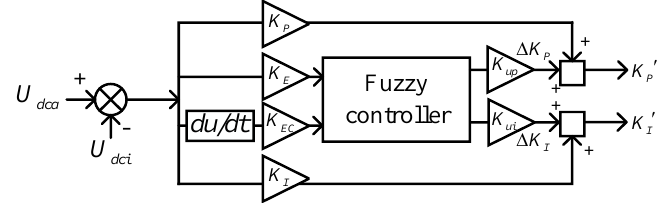
Figure 8. Schematic diagram of a fuzzy PI controller.